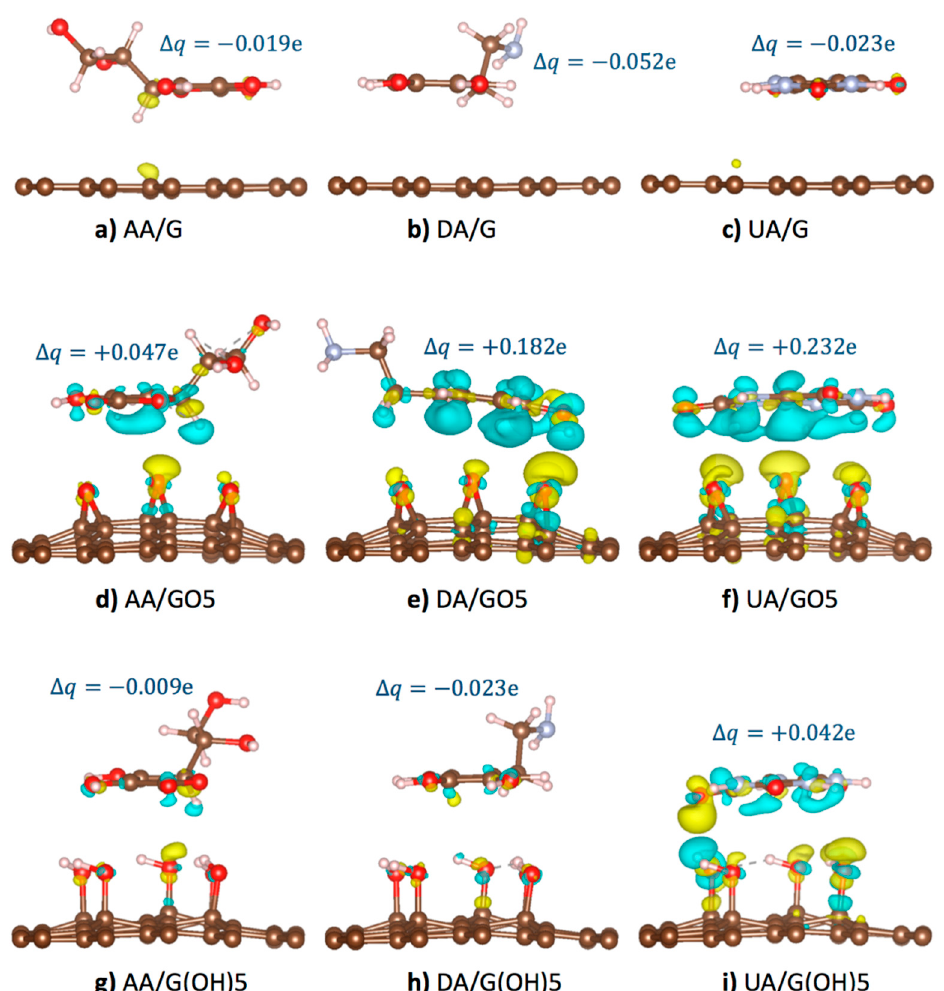
Figure 4. Optimized binding configurations, +0.001 e/Å 3 isosurfaces of charge density difference after substrate binding (light blue), and − 0.001 e/Å 3 isosurfaces of charge density difference after substrate binding (yellow) of the ( a ) AA/graphene, ( b ) DA/graphene, ( c ) UA/graphene, ( d ) AA/GO5, ( e ) DA/GO5, ( f ) UA/GO5, ( g ) AA/G(OH)5, ( h ) DA/G(OH)5, and ( i ) UA/G(OH)5 systems. Total change ∆ q of the charge on the analyte molecules is given for each system.